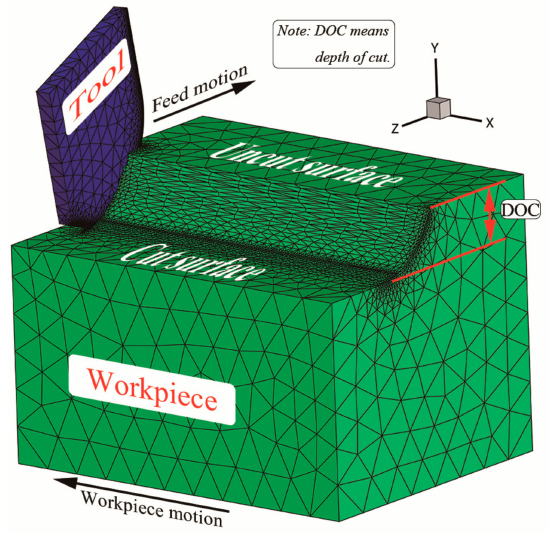
Figure 2. The simplified diagram of 3D finite element turning. Table 1. Physical and mechanical properties of Inconel 718